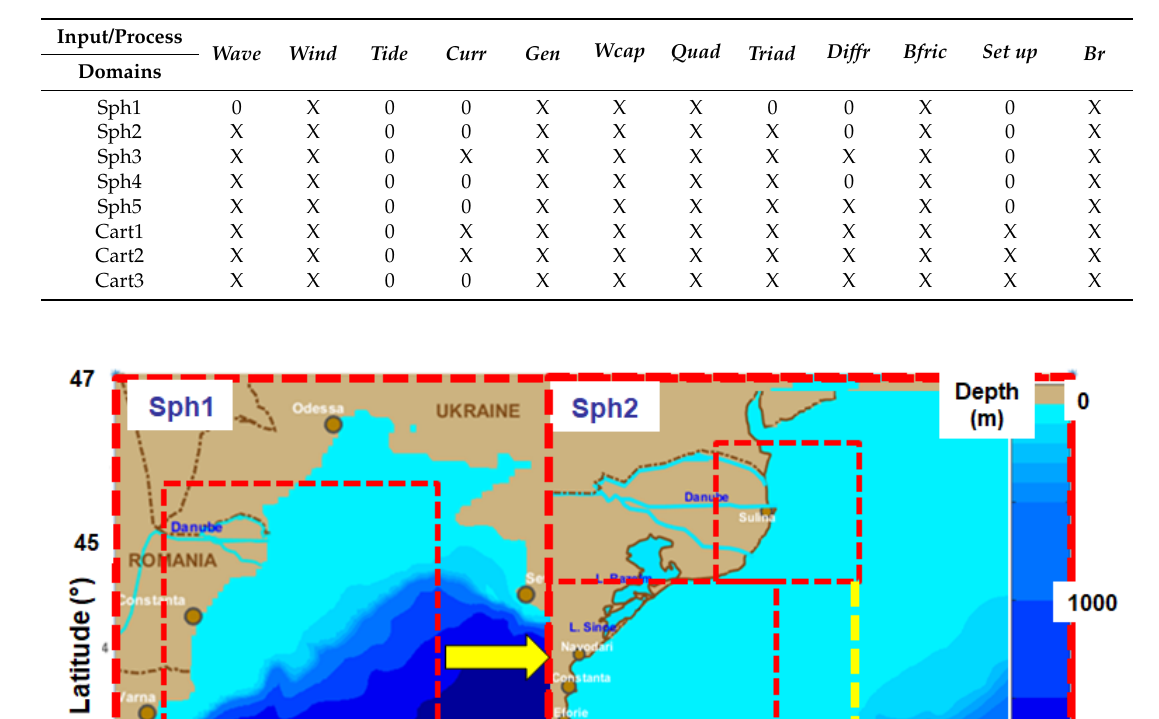
Physical processes activated in the SWAN simulations, corresponding to the eight computational domains defined. X—process activated, 0—process inactivated.